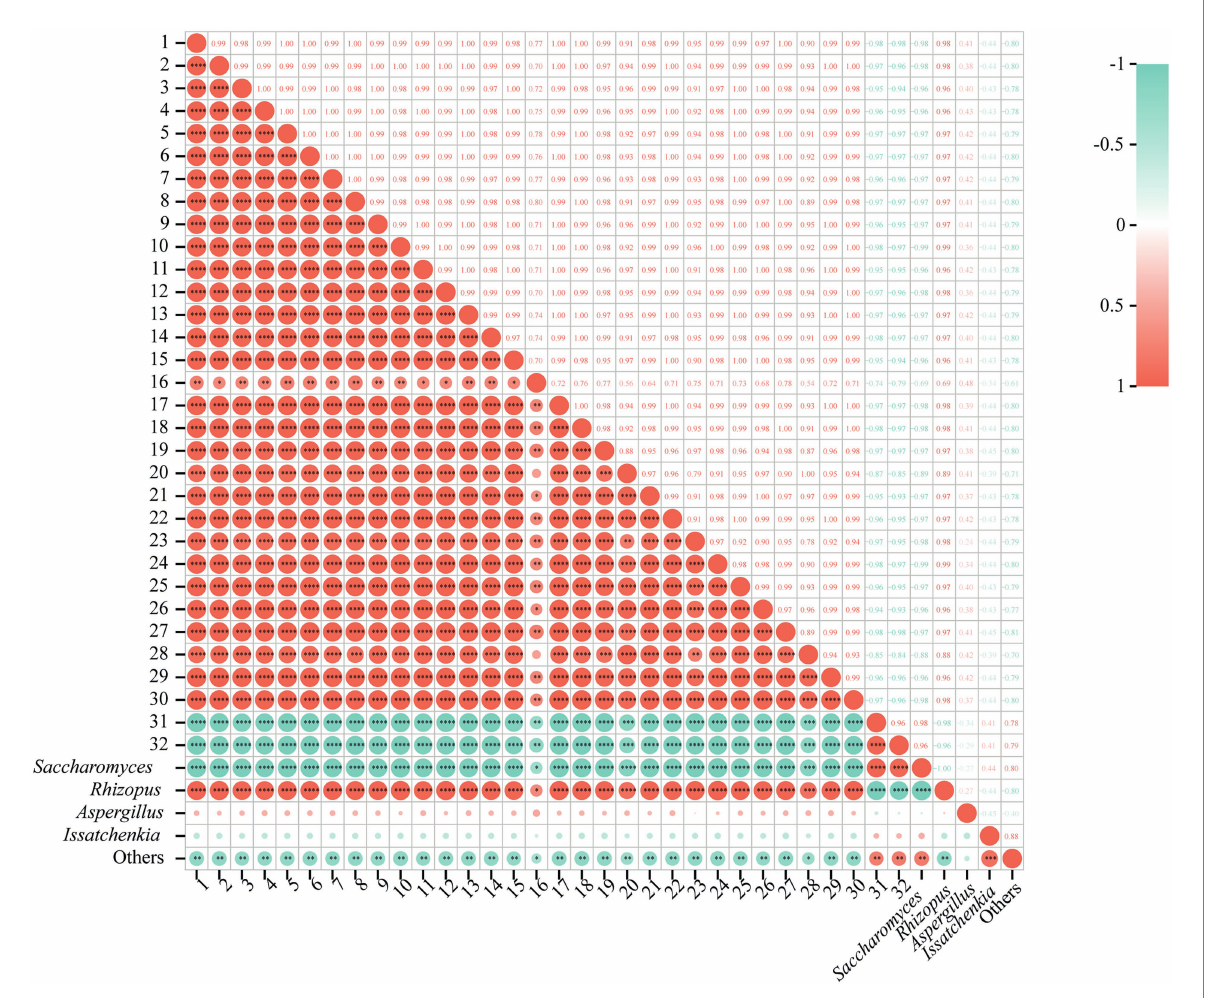
FIGURE 6 Correlation between fungi and nVFCs. 1 ~ 32, same as Figure 5. * p < 0.05, ** p < 0.01, *** p < 0.001, **** p <